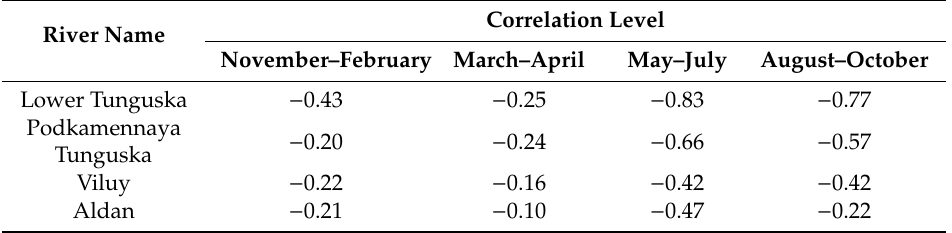
Table 2. Inverse dependence correlation between the discharge anomalies per season of year and RBA.